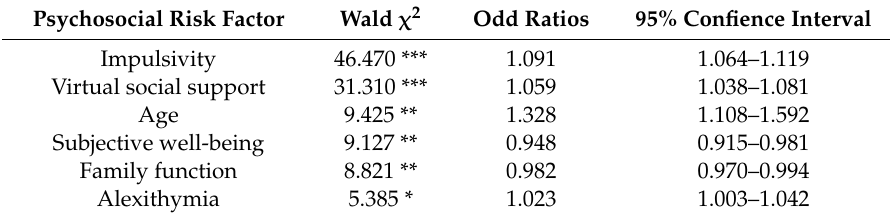
Table 3. Forward logistic regression analyses in predicting IA from socio-demographic and psychosocial risk